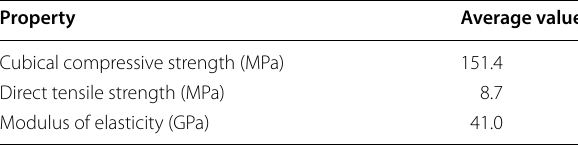
Table 5 Mechanical properties of